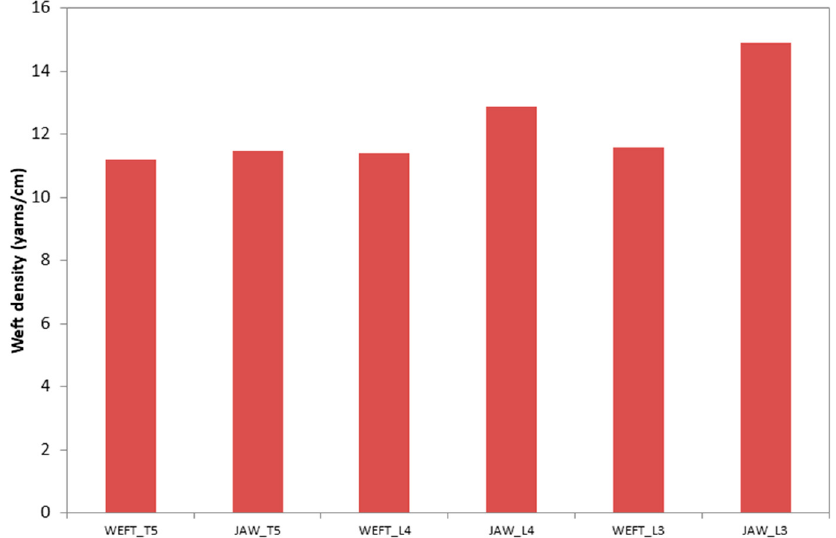
Figure 5. Measured weft densities of the six 3D warp interlock fabrics.